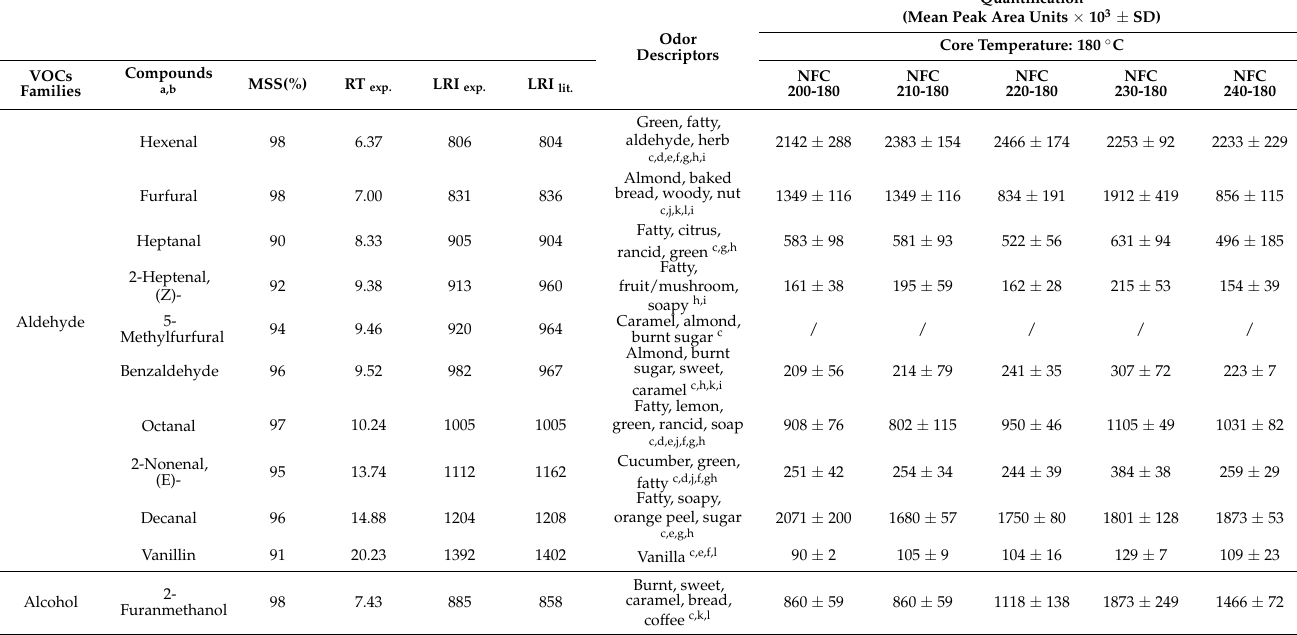
Table A1. Volatile organic compounds coming from flax fibers of NFC shaped for heat press tempera- tures between 200 and 240 ◦ C for different core temperatures